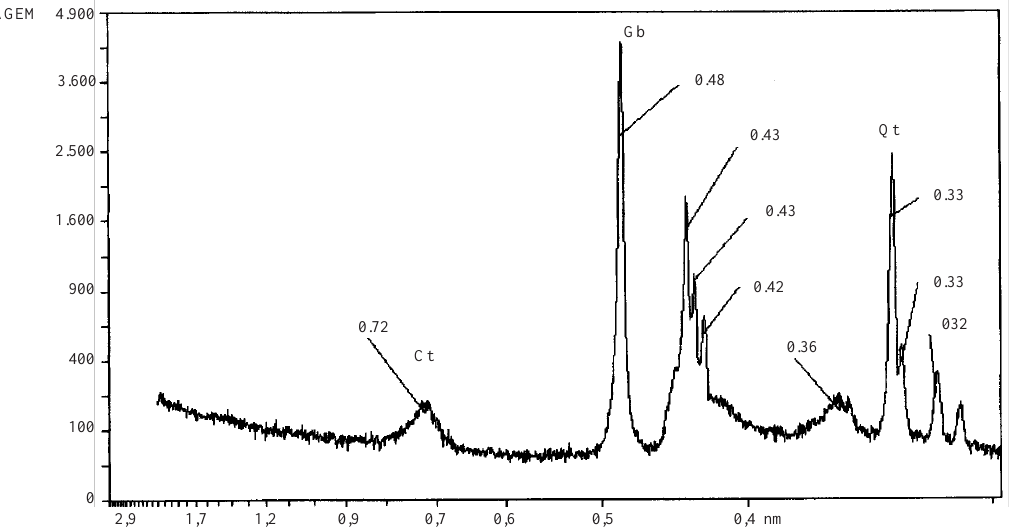
Figura 4. Difratograma do pó dos nódulos brandos do horizonte BC do perfil P1. (Gb = gibbsita; Ct = caulinita; Qt =